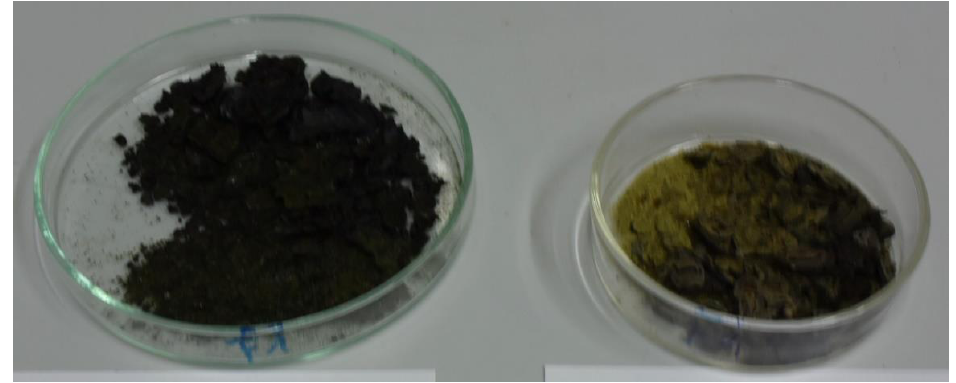
Figure 6. Dried biomasses from cultivation of Synechocystis sp. IFA-3 ( left ) and Chlorogloeopsis sp. Heinrichs-4 ( right ) in the 5-L tubular photobioreactor.